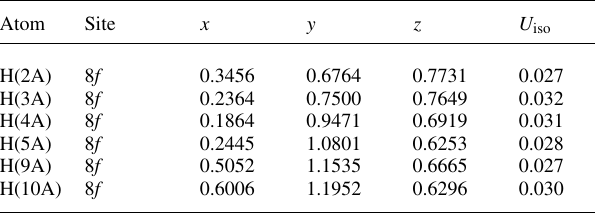
Table 2. Atomic coordinates and displacement parameters (in Å 2 )